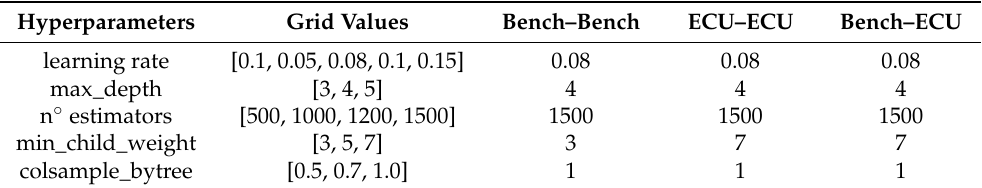
Table 8. Best XGBoost architectures and grid values setup for the three case studies under investiga- tion. The mean squared error (MSE) evaluation metric was used to obtain the optimal value by the GridsearchCV algorithm. Hyperparameters Grid